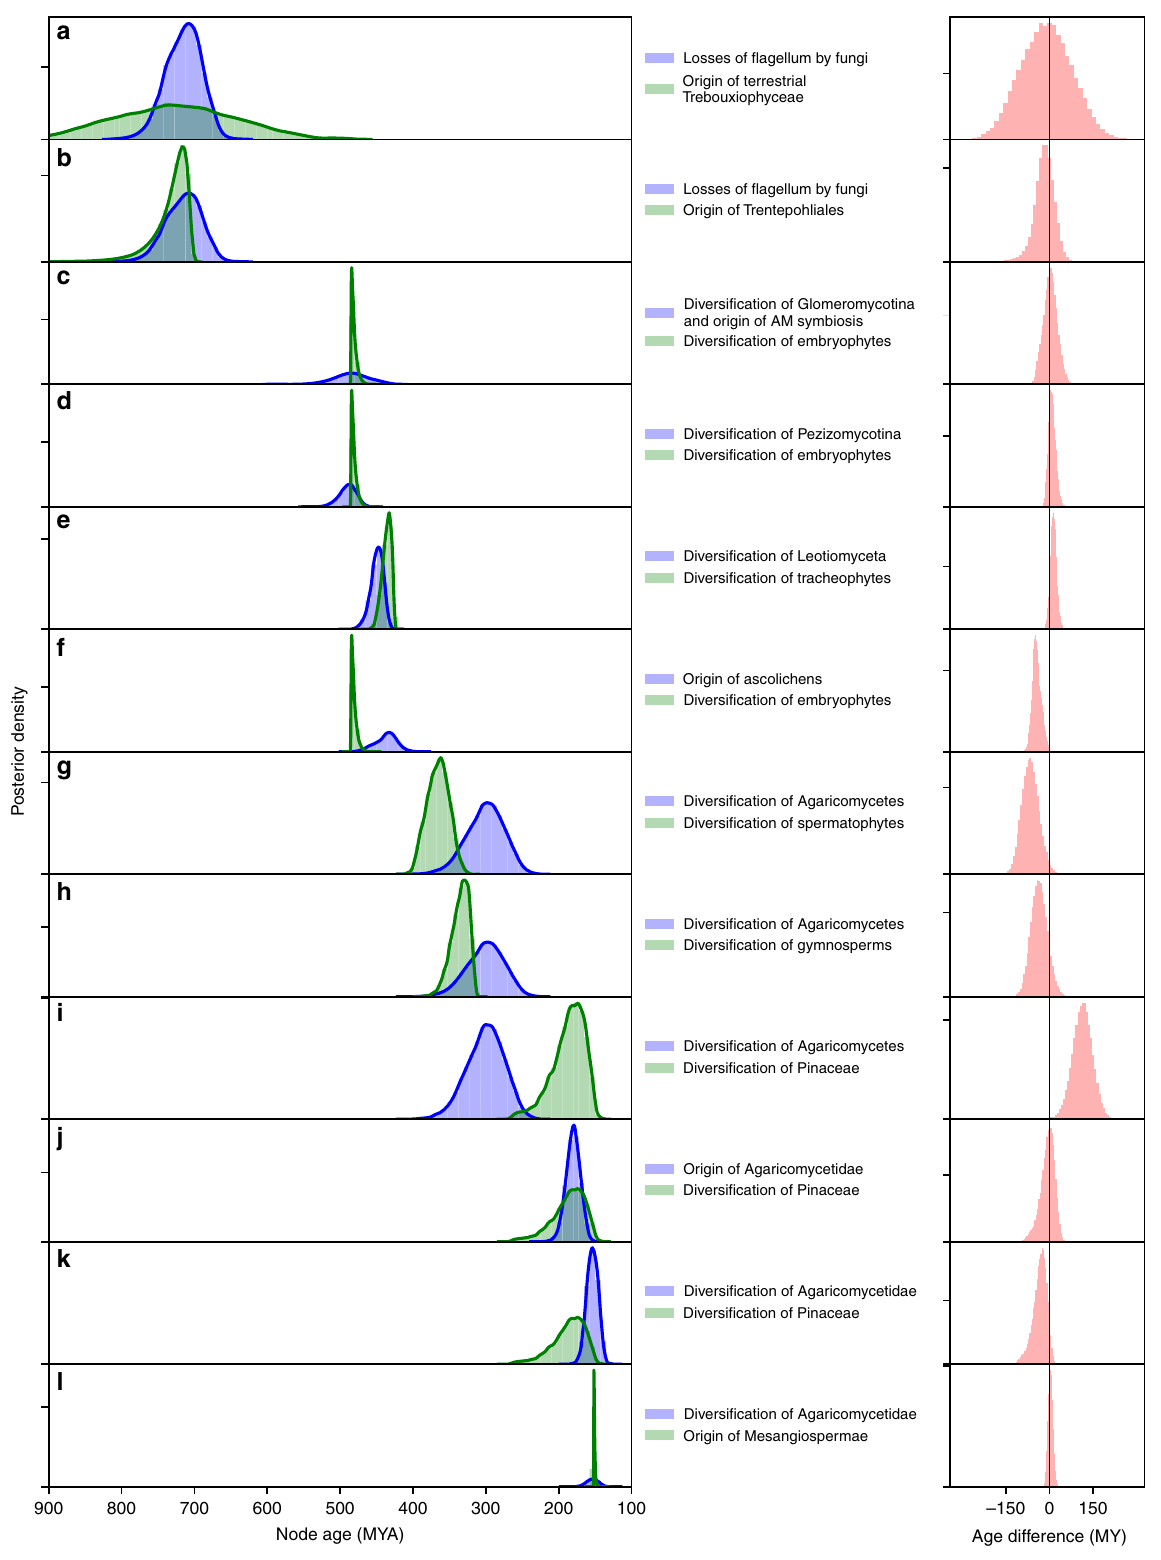
Fig. 2 Pairwise comparison of selected land plant and fungal divergence times (node ages) posterior densities and their differences. a – l Positive age differences indicate that the fungal evolutionary event preceded the plant evolutionary event; negative age differences indicate that the plant evolutionary event preceded the fungal